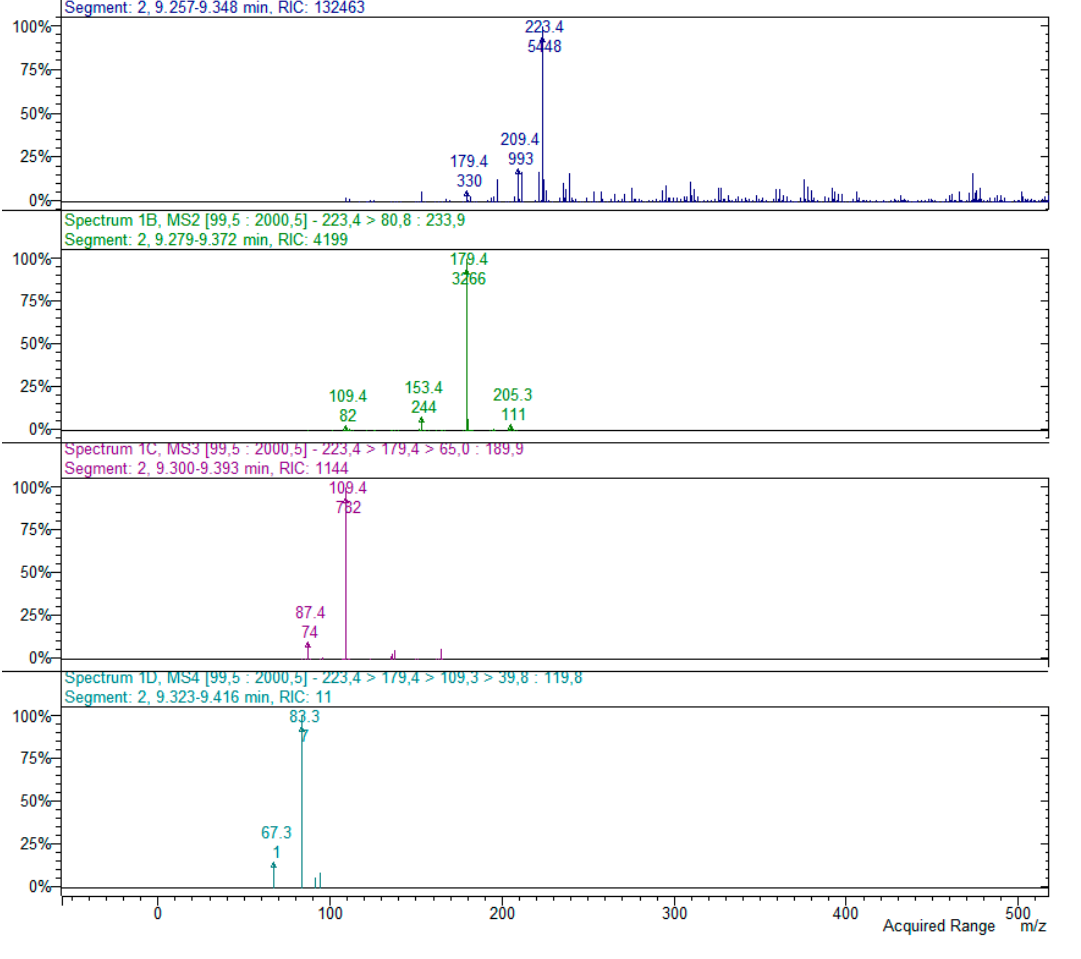
Figure 3. MS n spectra ( n = 4) of 3 (cid:48) 3 (cid:48) me6 (cid:48) oxoPIB, [M-H] − = 223. The spectra show the main fragments formed by the sequential fragmentation of the parent compound ( m / z 223 > 179) and its main products ( m / z 179 > 109; m / z 109 > 83). The structures of the main fragments are reported in the scheme in Figure